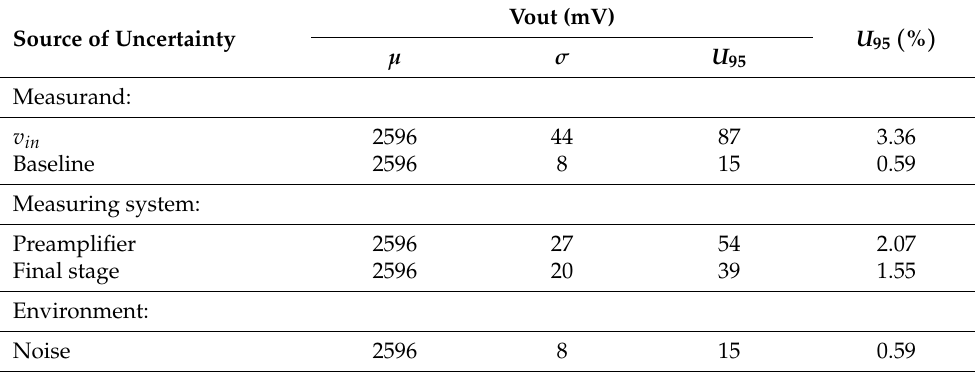
Table 3. Individual or block simulation of uncertainty